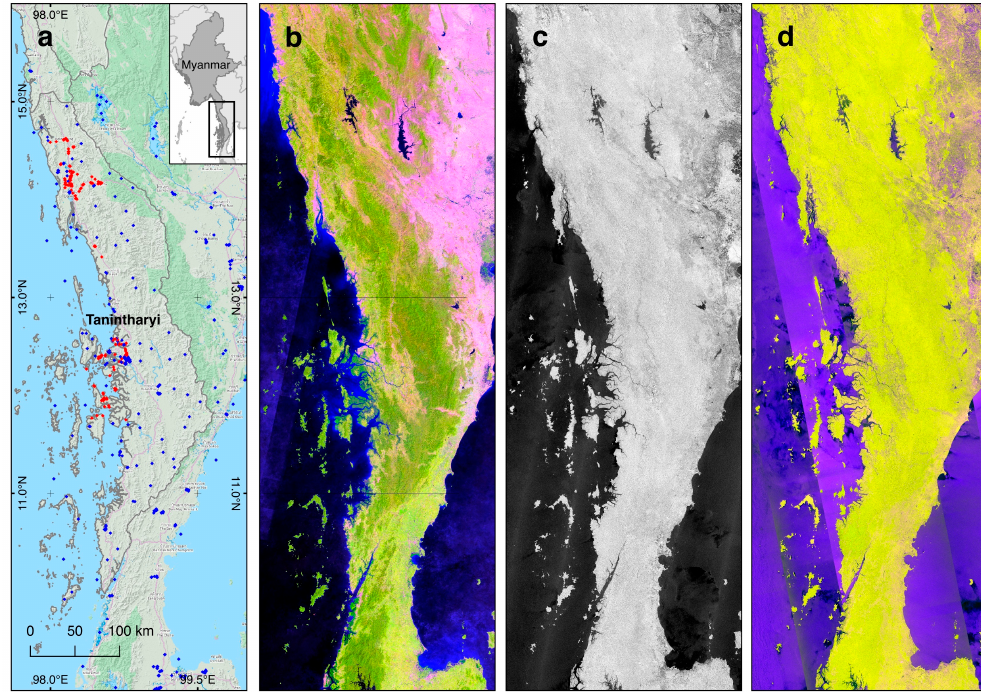
Figure 1. ( a ) Location of the Tanintharyi Region, southern Myanmar with regions of interest based on ground truth data highlighted in red and interpreted from high resolution imagery in blue. The satellite images shown are ( b ) 2015 Landsat 8 OLI (false color, RGB = 543); ( c ) 1995 JERS-1 SAR (grayscale, HH); and ( d ) 2015 ALOS-2/PALSAR-2 (false colour, RGB = HH/HV/HH-HV).